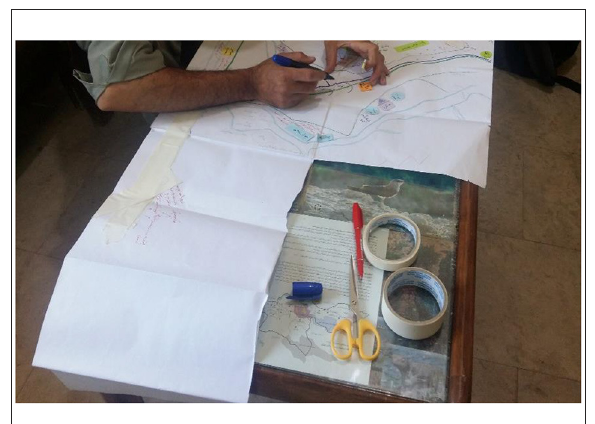
FIGURE6 Work with locals- Ab-e Ask village.